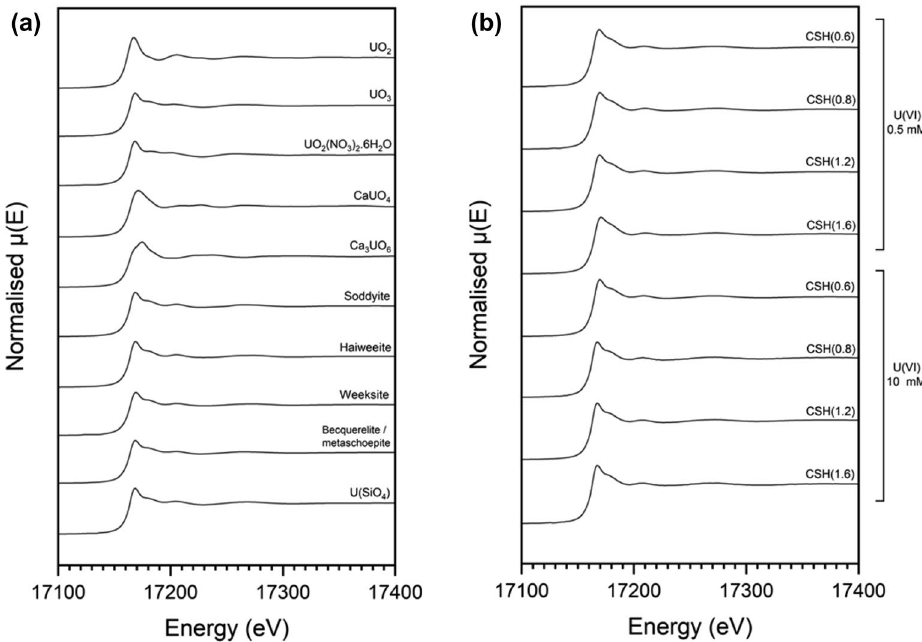
Figure 4. Uranium L III -edge X-ray absorption spectra. For ( a ) U ceramic and mineral standards and; ( b ) U(VI)-contacted C–S–H phases. Soddyite =